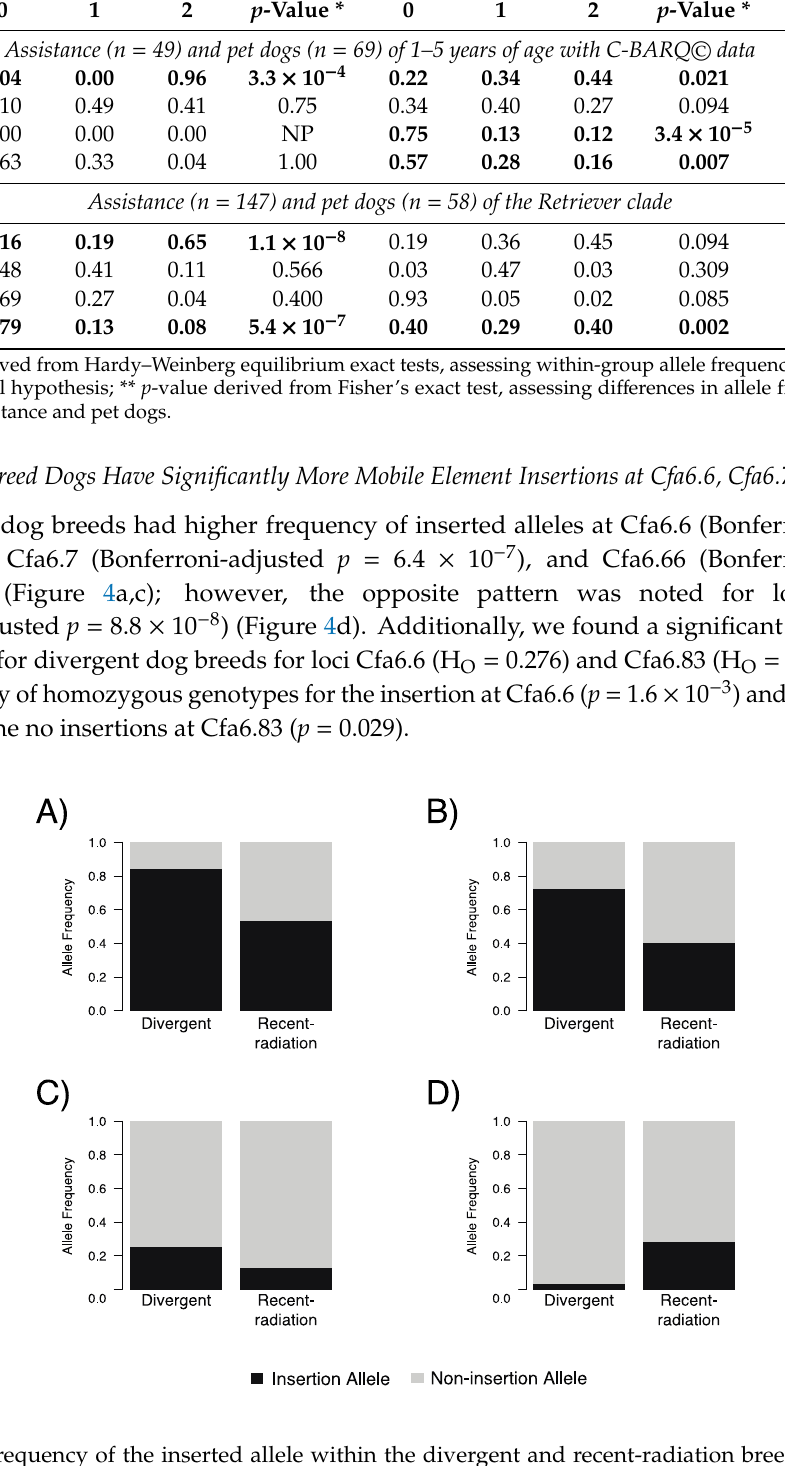
Figure 4. Frequency of the inserted allele within the divergent and recent-radiation breed groups, respectively, at each locus: ( A ) Cfa6.6; ( B ) Cfa6.7; (C ) Cfa6.66; and ( D ) Cfa6.83.